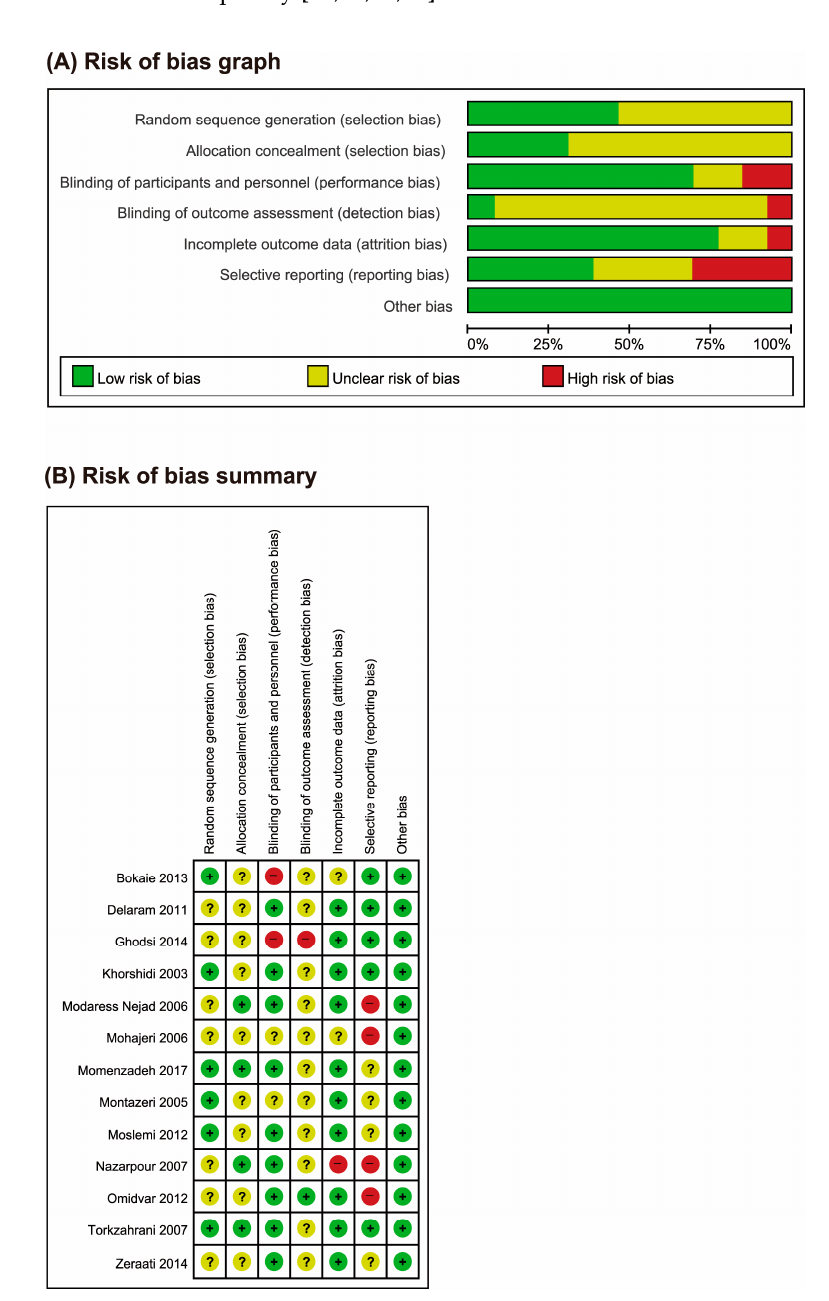
Figure 2. ( A ) Risk of bias graph: review authors’ judgments about each risk of bias item presented as percentages across all included studies. ( B ) Risk of bias summary: review authors’ judgments about each risk of bias item for each included study. +: low risk of bias; − : high risk of bias; ?: unclear risk of bias.